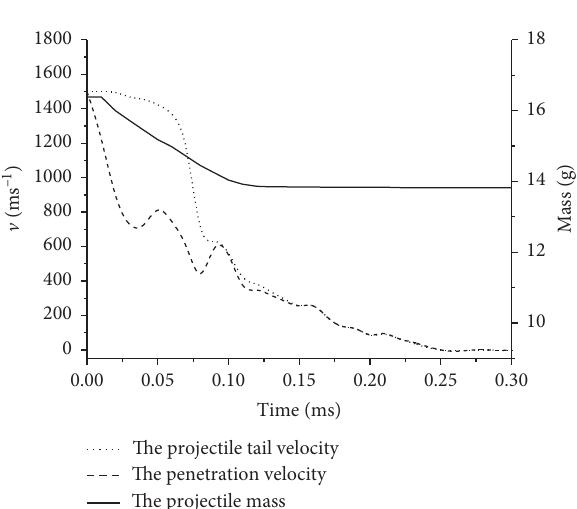
Figure 5: Time course changes of the projectile tail velocity, penetration velocity, and projectile